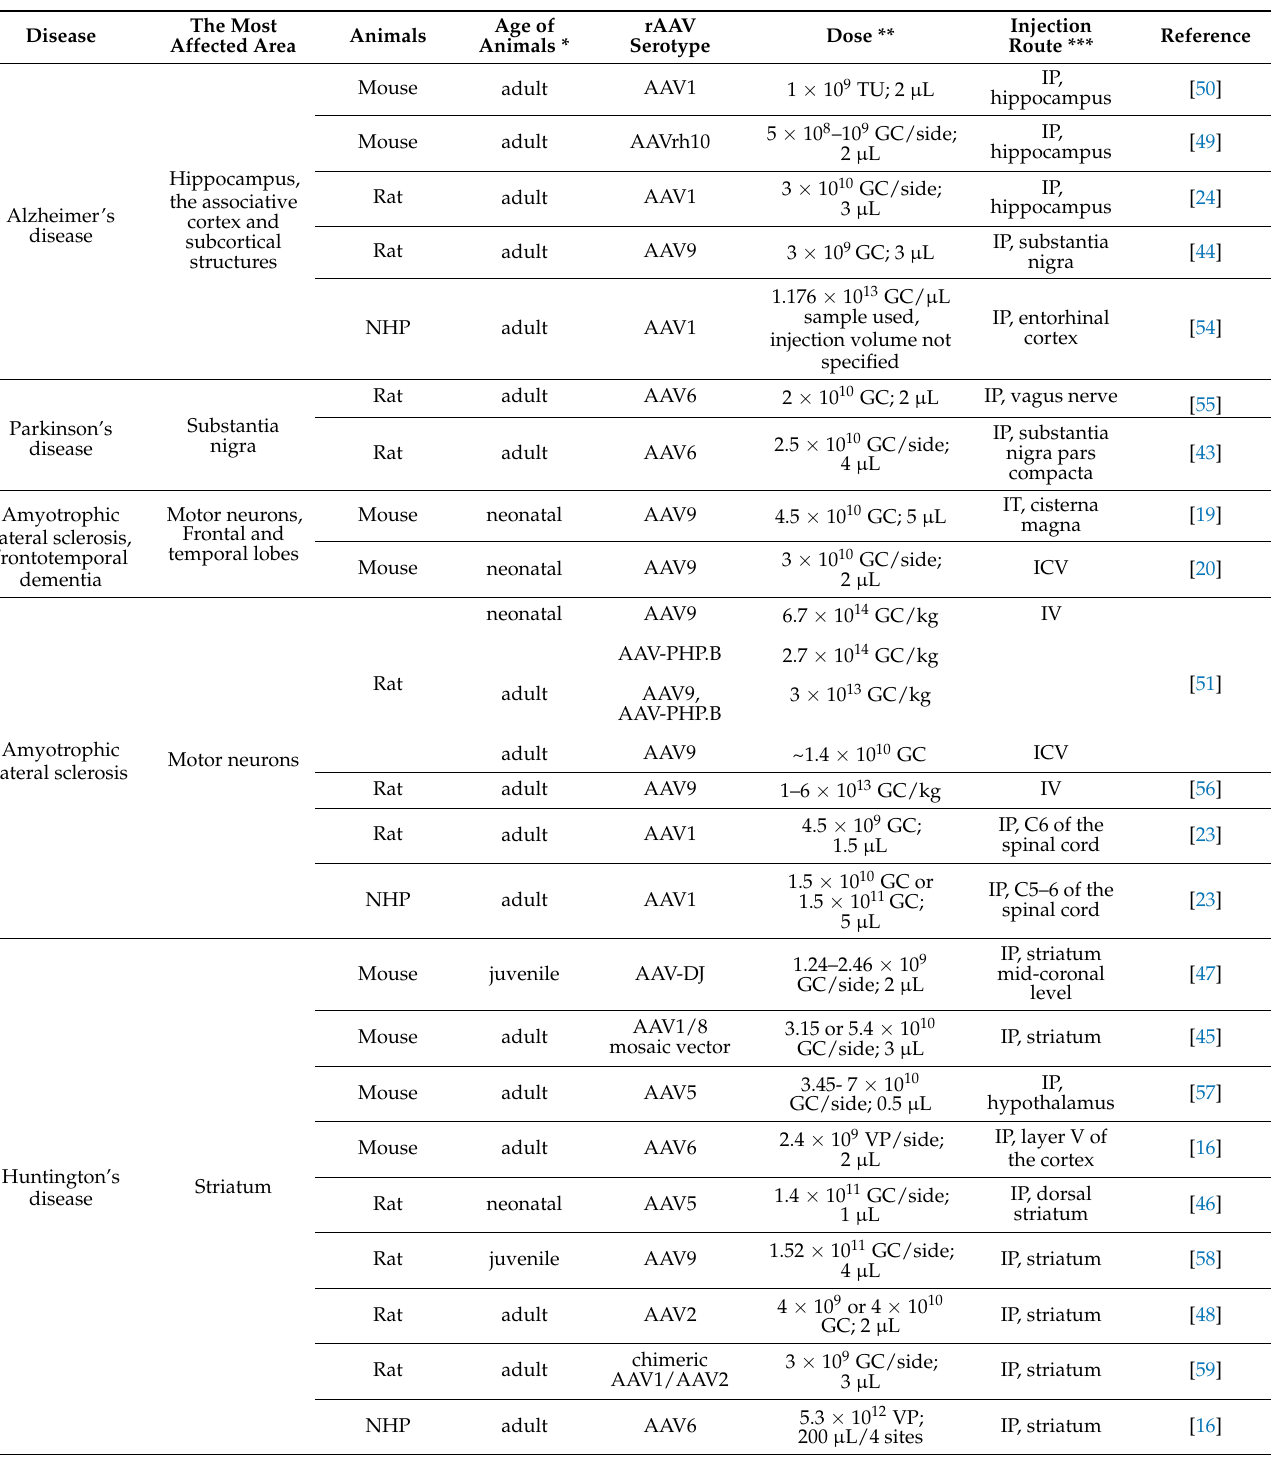
Table 1. Key features of experiments on AAV-mediated targeting of different areas of the CNS to model neurological